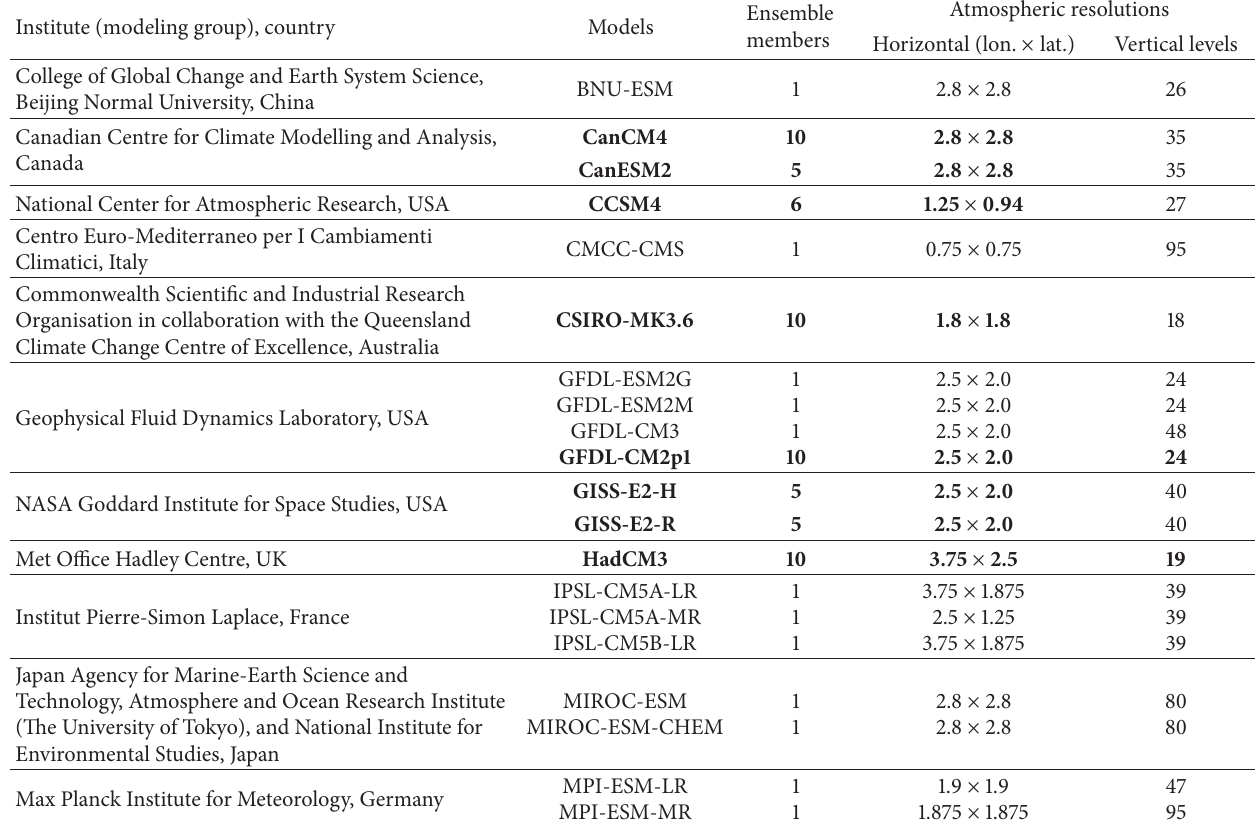
Table 1: List of CMIP5 models used in this study. Models in bold are those CMIP5 models that have at least five ensemble members for both historical and future (RCP4.5)